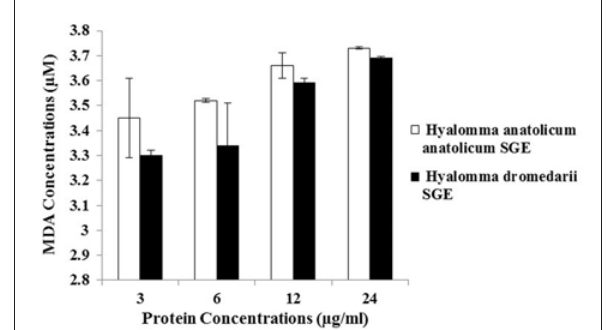
Figure-5: Malondialdehyde concentration in salivary gland extracts of Hyalomma anatolicum anatolicum and Hyalomma dromedarii ticks. Data presented as mean±standard error; N=6 Groups, each group containing six ticks.